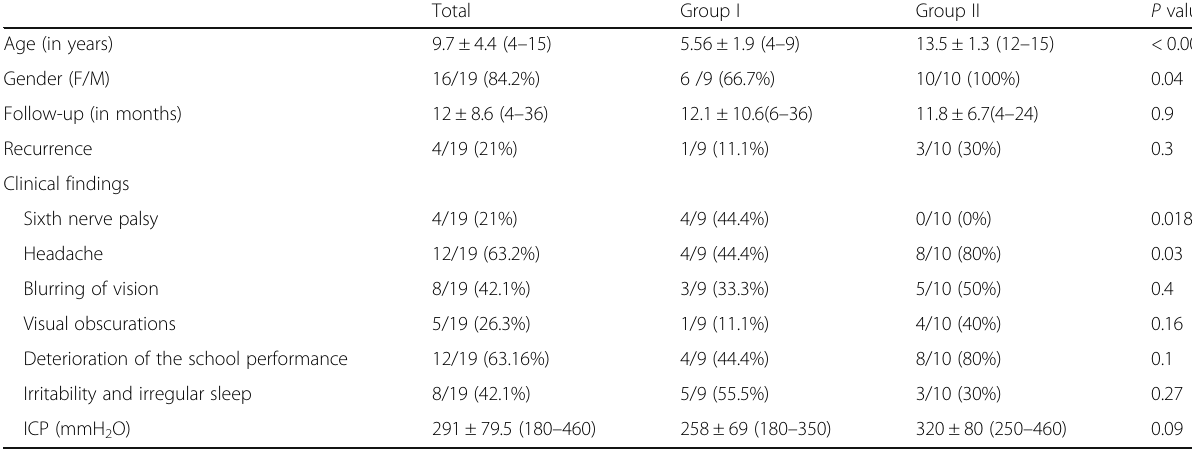
Table 1 Epidemiological and clinical